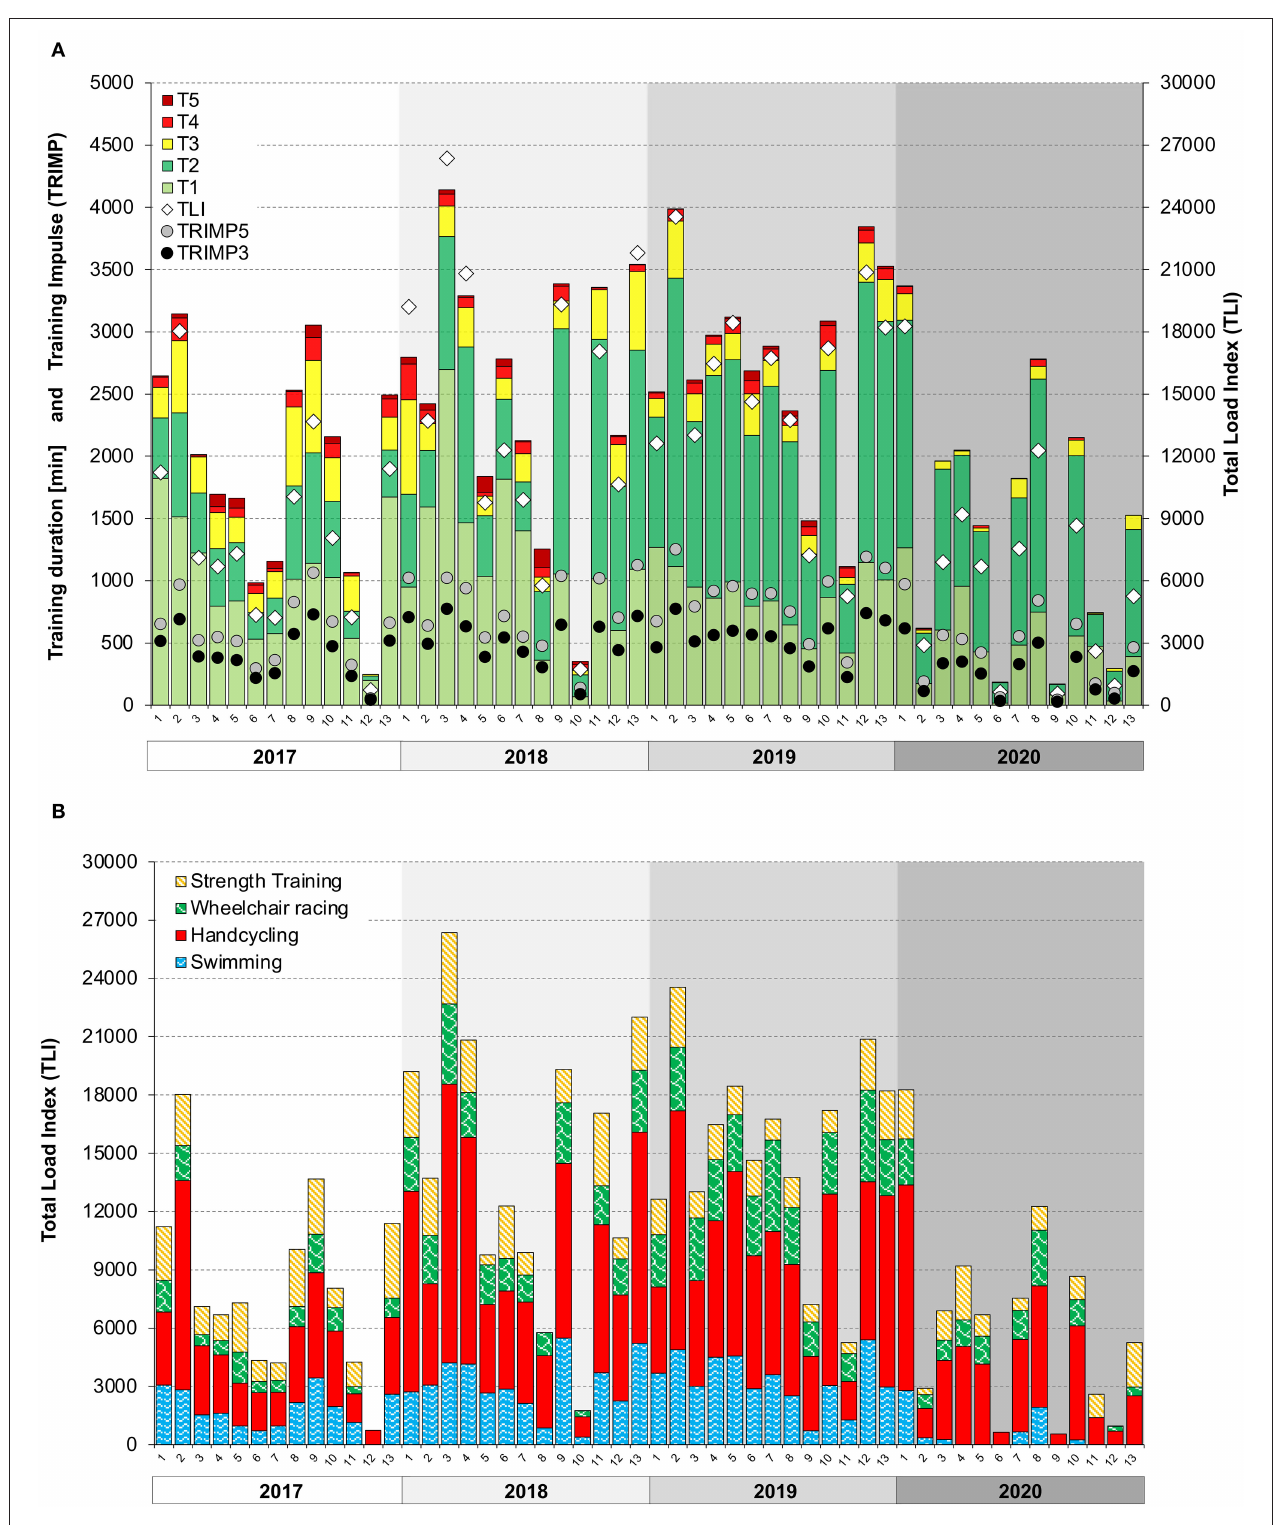
FIGURE 3 | Training monitoring from 2017 to 2020. (A) Total training duration in every exercise zone (T1–T5) over time in 4-week blocks (13 for each year). TRIMP and total load index (TLI) over time in 4-week blocks (13 for each year). (TRIMP 3 ), training impulse based on a three-zone model; TRIMP 5 , training impulse based on a five-zone model; TLI, total load index; sRPE × training duration [min]. (B) TLI in every discipline over time in 4-week blocks (13 for each year). TLI, total load index; sRPE × training duration (min).